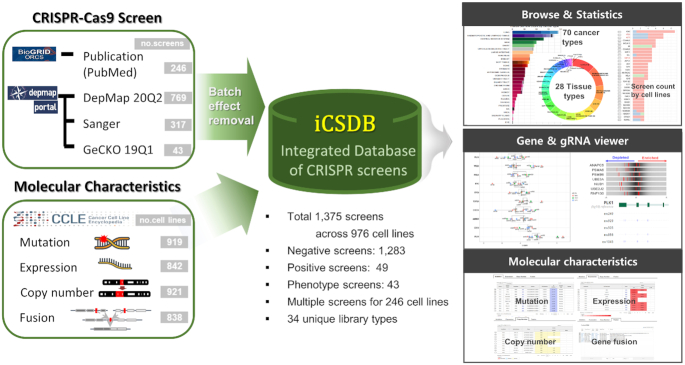
Overview of iCSDB.